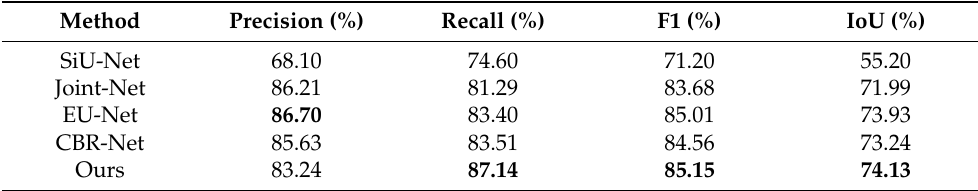
Table 6. Quantitative comparison of MEC-Net using the Massachusetts dataset.